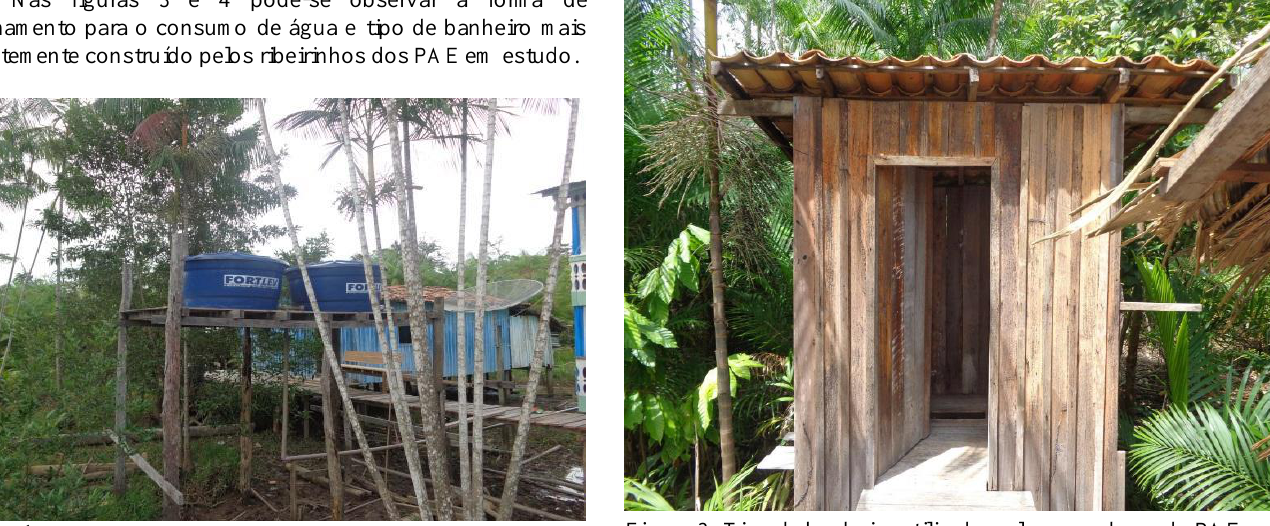
Figura 3: Água do rio acondicionada em caixas de PVC Fonte: IATAM, (2015).